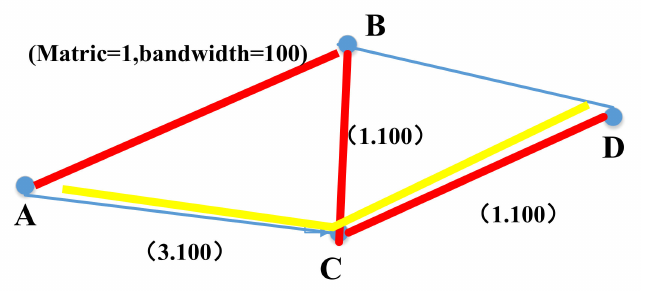
Figure 3. KSP algorithm